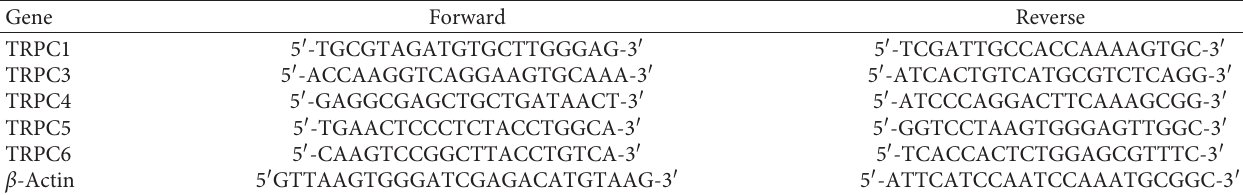
Table 1: Primer sequences used in the